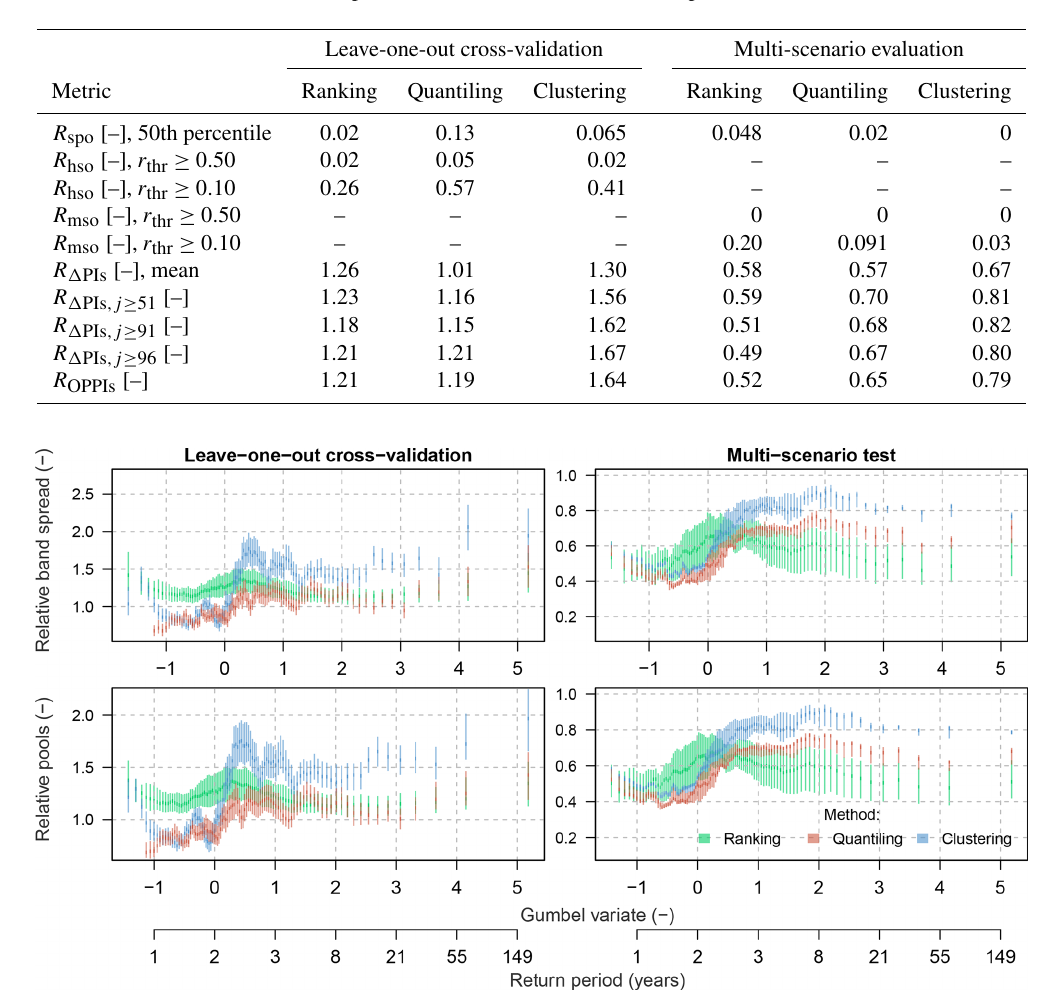
Figure 10. Evaluation of the leave-one-out cross-validation and the multi-scenario test for the three selection methods using the relative band spread ( R (cid:49) PIs ) and the relative overlapping pools ( R OPPIs ), both computed with reference to the 90% PIs of the full hydrological-simulation